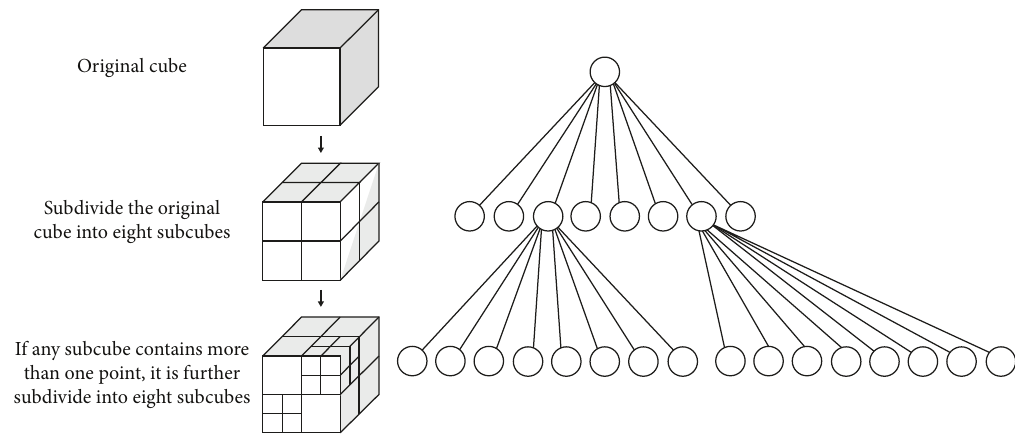
Figure 1: Building an Orthtree in 3D (octree) from a point cloud.